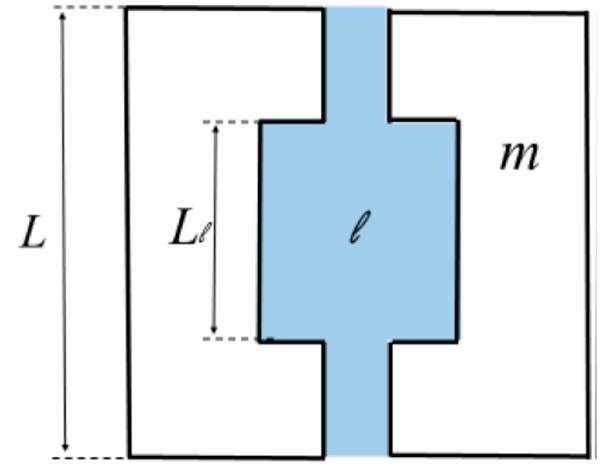
Figure 10 . Actual pore geometry of length 𝐿 in the uniform capillary model of [176]. Figure 10. Actual pore geometry of length L in the uniform capillary model of